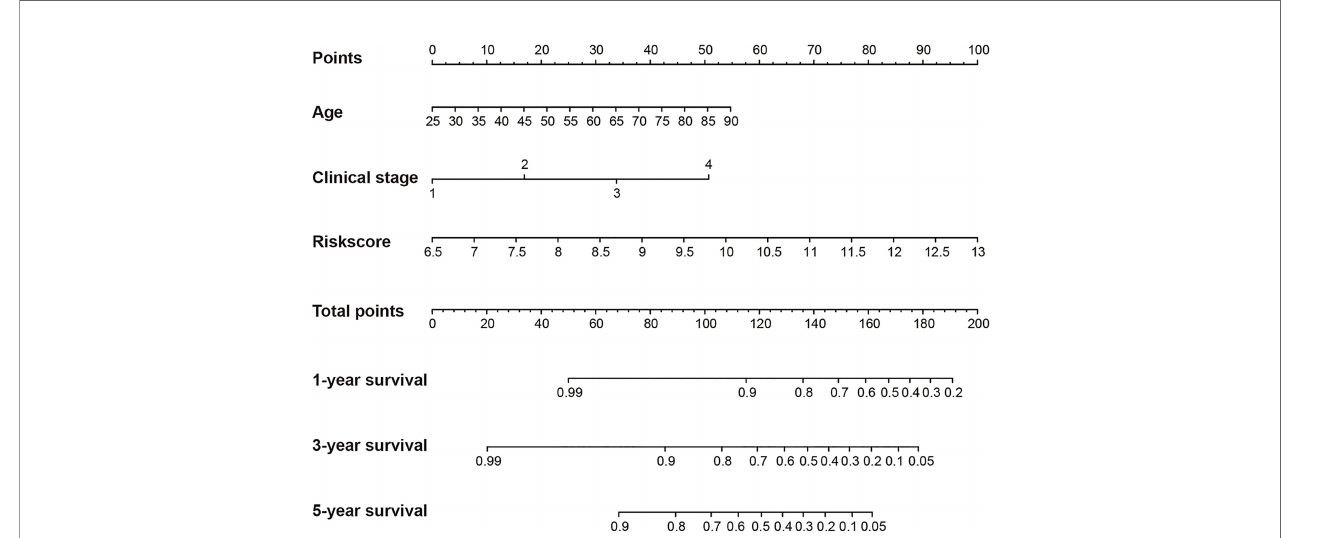
FIGURE 6 | Construction of a nomogram for overall survival prediction in KIRC. The nomogram consists of age, clinical stage and the riskscore based on the six- hypoxia gene model.